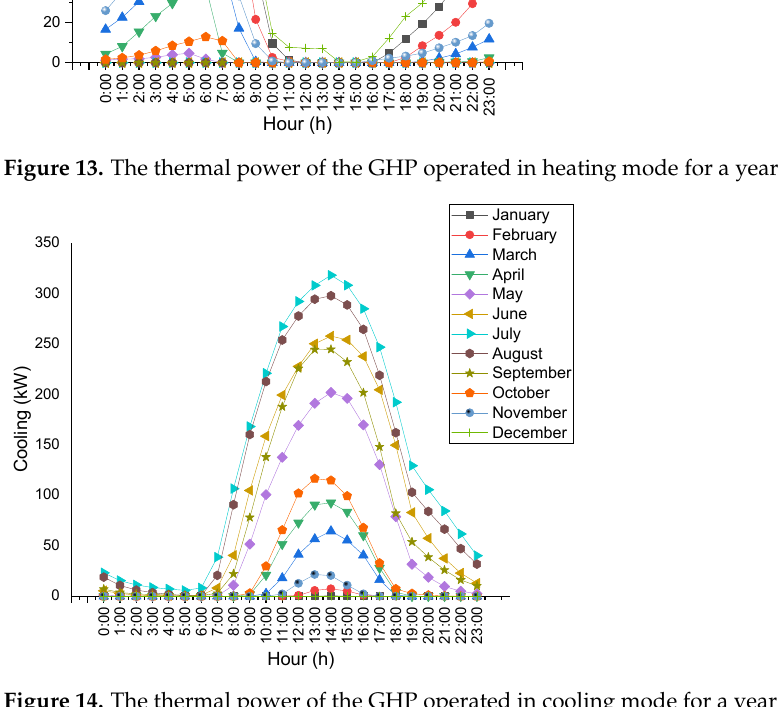
Figure 13. The thermal power of the GHP operated in heating mode for a year in Mexicali, Mexico.